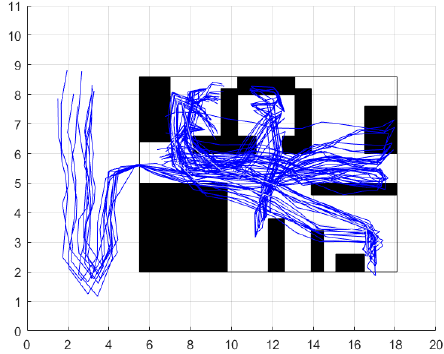
Figure 7. Results of participant’s localization. The blue lines are the 10 trajectories reconstructed for each participant. The description of each image has the sequence followed by the participant.